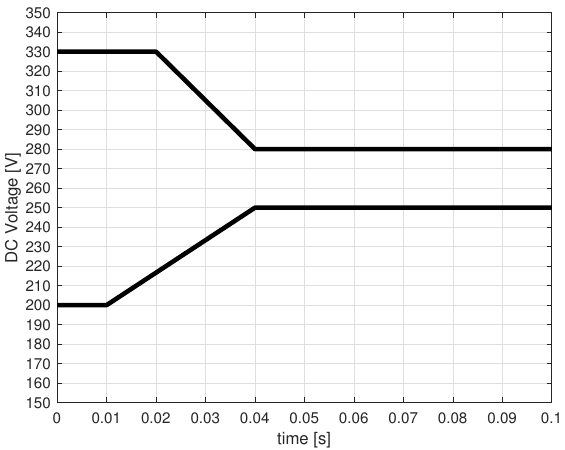
Figure 16. Envelope of admissible voltage transient for 270 V.